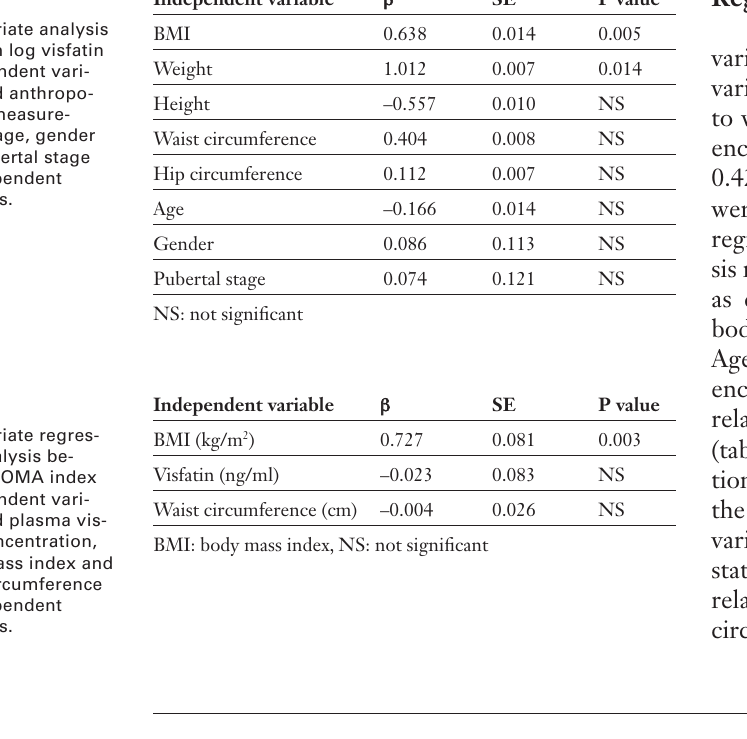
Multivariate analysis between log visfatin as dependent vari- able and anthropo- metric measure- ments, age, gender and pubertal stage as independent variables.